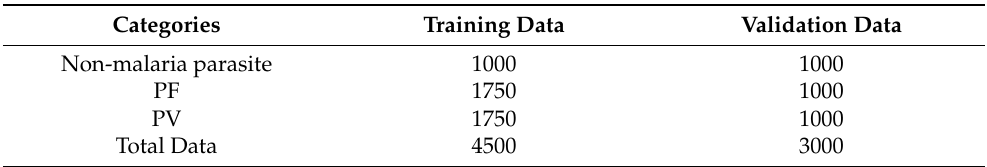
Table 1. Training and validation data distributions for the thick smear.